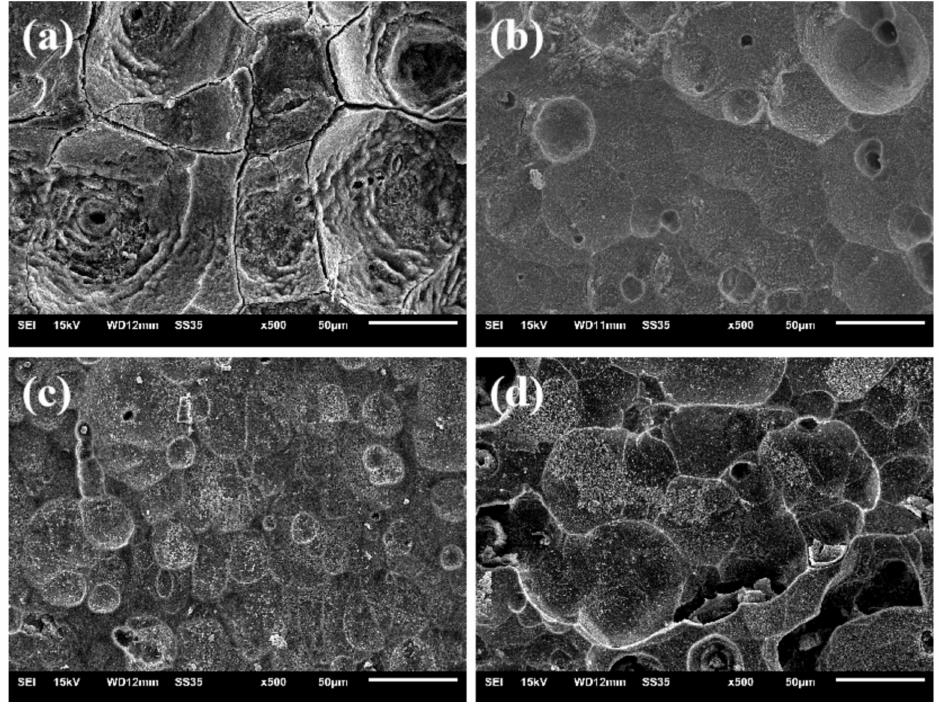
Figure 7. The surface morphologies of the Al-1Zn-0.1In-0.1Sn-0.5Mg-xMn (x = 0, 0.1, 0.2, 0.3) (wt.%) alloy anodes after discharging at 20 mA · cm − 2 for 4 h in the 4 M NaOH solution; ( a ) x = 0, ( b ) x = 0.1, ( c ) x = 0.2, ( d ) x =